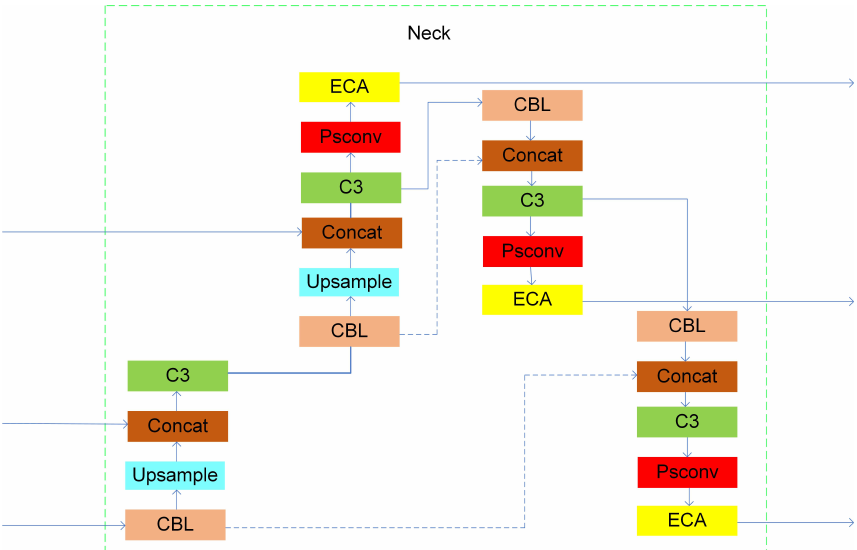
Figure 6. PE-Neck structure schematic. The integration of the PSconv and ECA modules in the neck part of the original algorithm does not connect from the